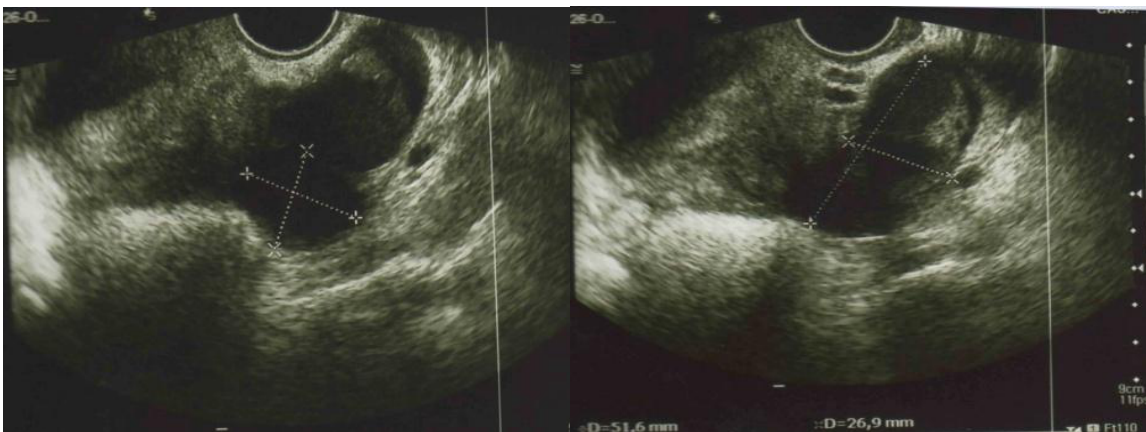
Figure 2. Transvaginal pelvic ultrasound shows cystic structures with low level internal echoes and echogenic wall foci, thickened walls and